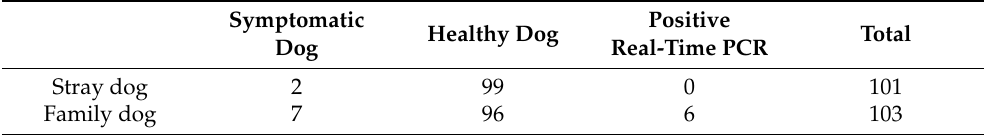
Table 1. Leptospira identification in dog plasma samples by real-time